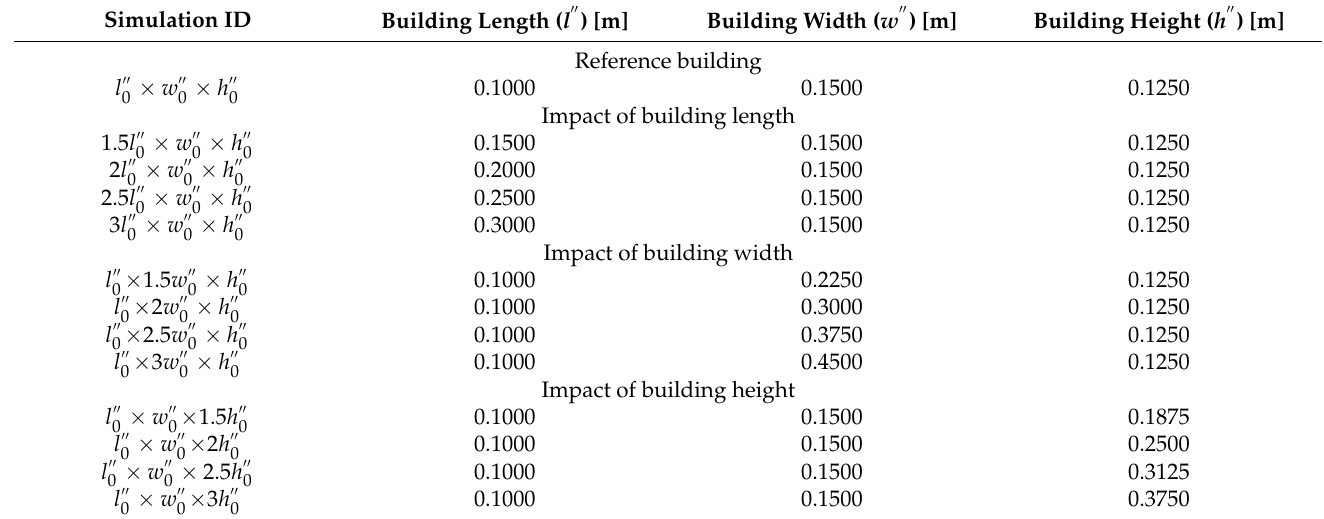
Table 2. An overview of the conducted simulations and the building dimensions in each case. The length, width and height of the computational domain is 3 m, 2 m and 1.5 m, respectively. Simulation